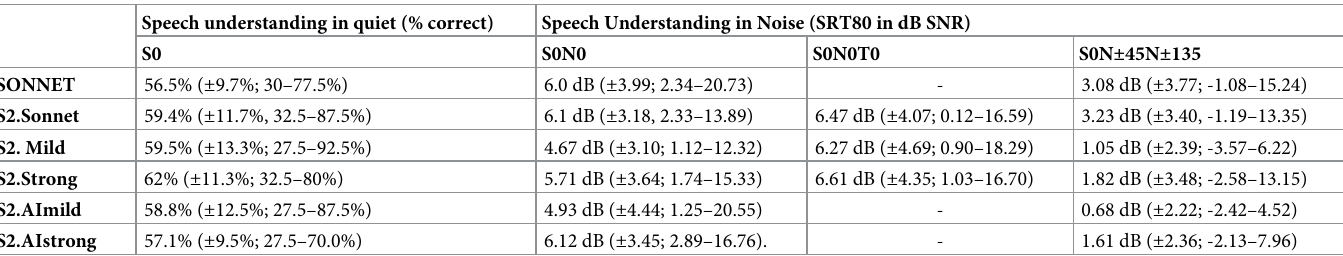
Table 4. Speech understanding scores (in mean, standard deviation, and range) in quiet and speech reception threshold (SRT80) for each device and setup. Speech understanding in quiet (% correct) Speech Understanding in Noise (SRT80 in dB